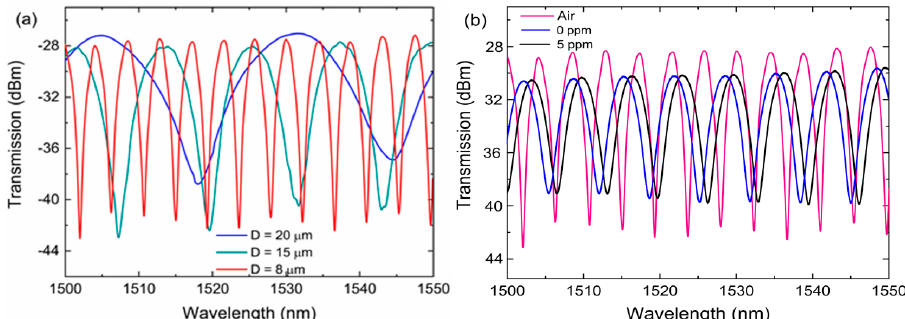
Figure 2. Transmission spectra of ( a ) MFI with different waist diameter D ( b ) 8 µm MFI in air, water, and 5 ppm ammonia nitrogen.